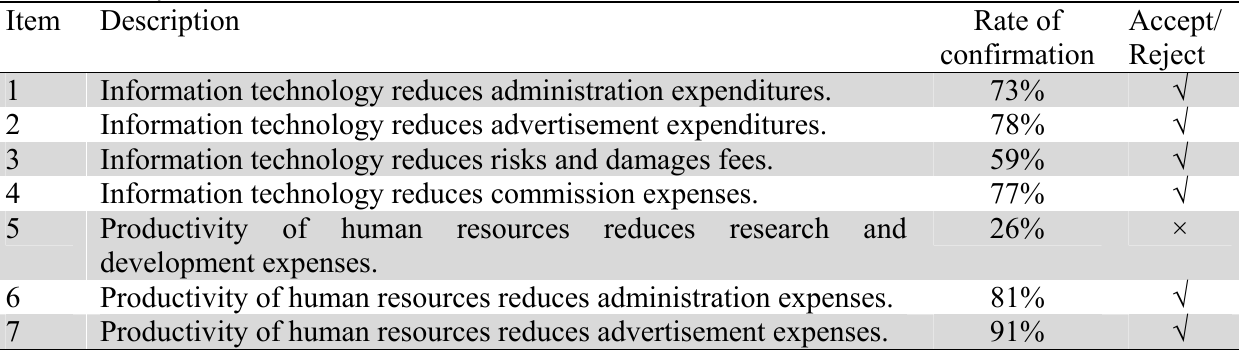
The summary of influential factors on cost